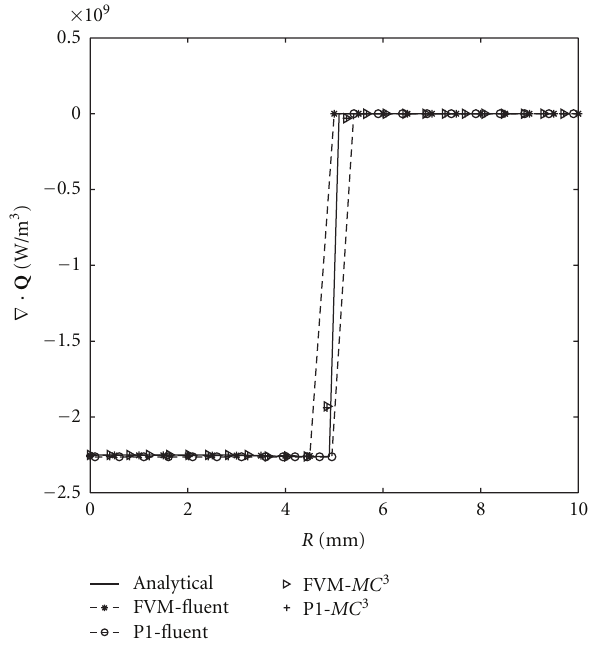
Figure 7: Test case III. Source term for a transparent band.